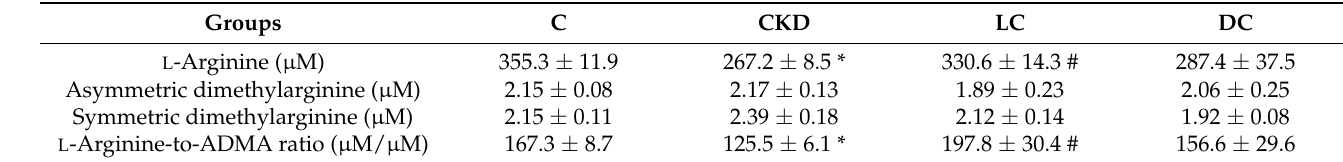
Table 4. Plasma NO parameters.